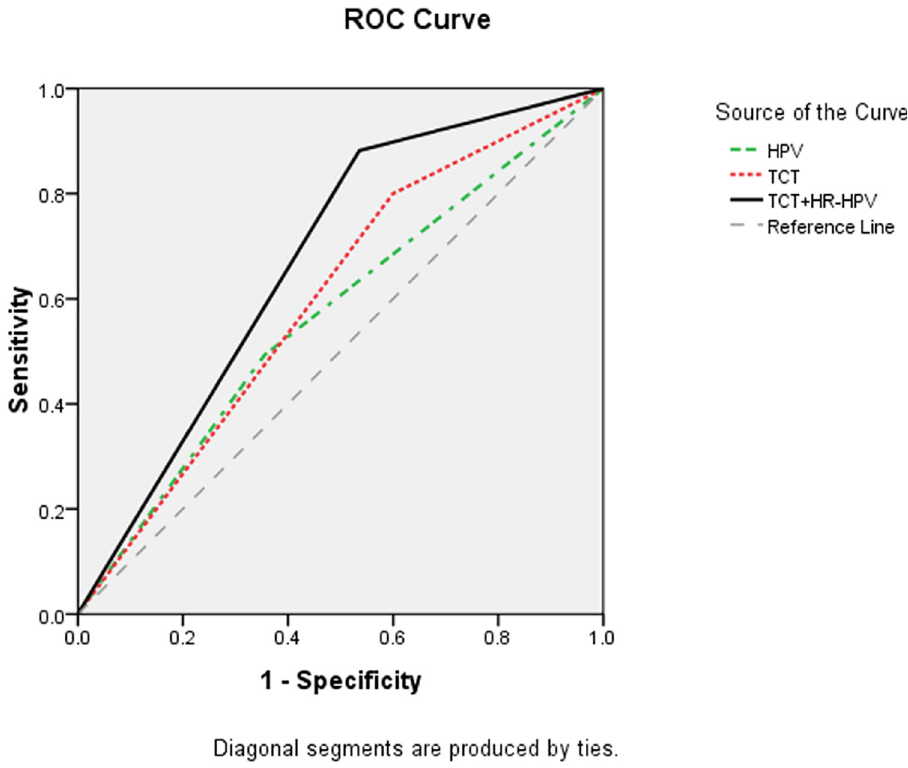
Fig 2. Receiver operating characteristic (ROC) curves of different screening strategies for 1622 patients with cervical